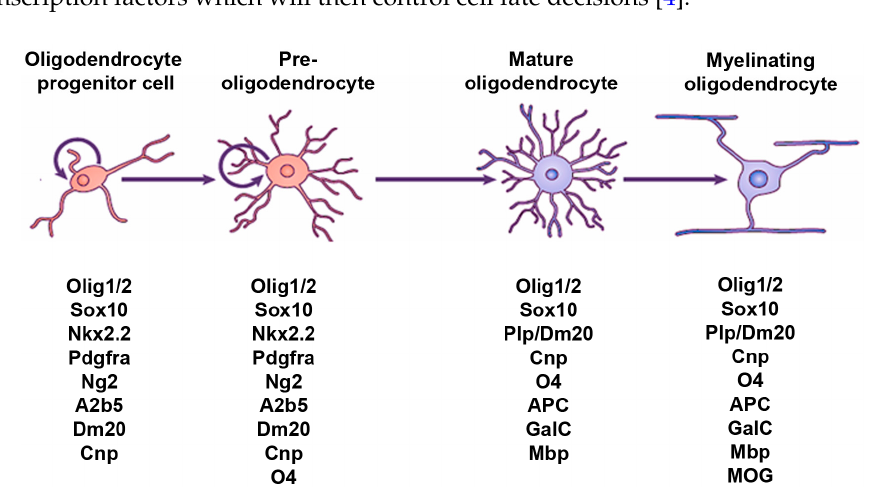
Figure 1. Schematic representation of the developmental stages of the OL lineage. The morphological (top) and antigenic (bottom) features of OPCs, pre-OLs, mature OLs and myelinating OLs are shown. The list of stage-specific markers is restricted to the markers quoted in the present review.